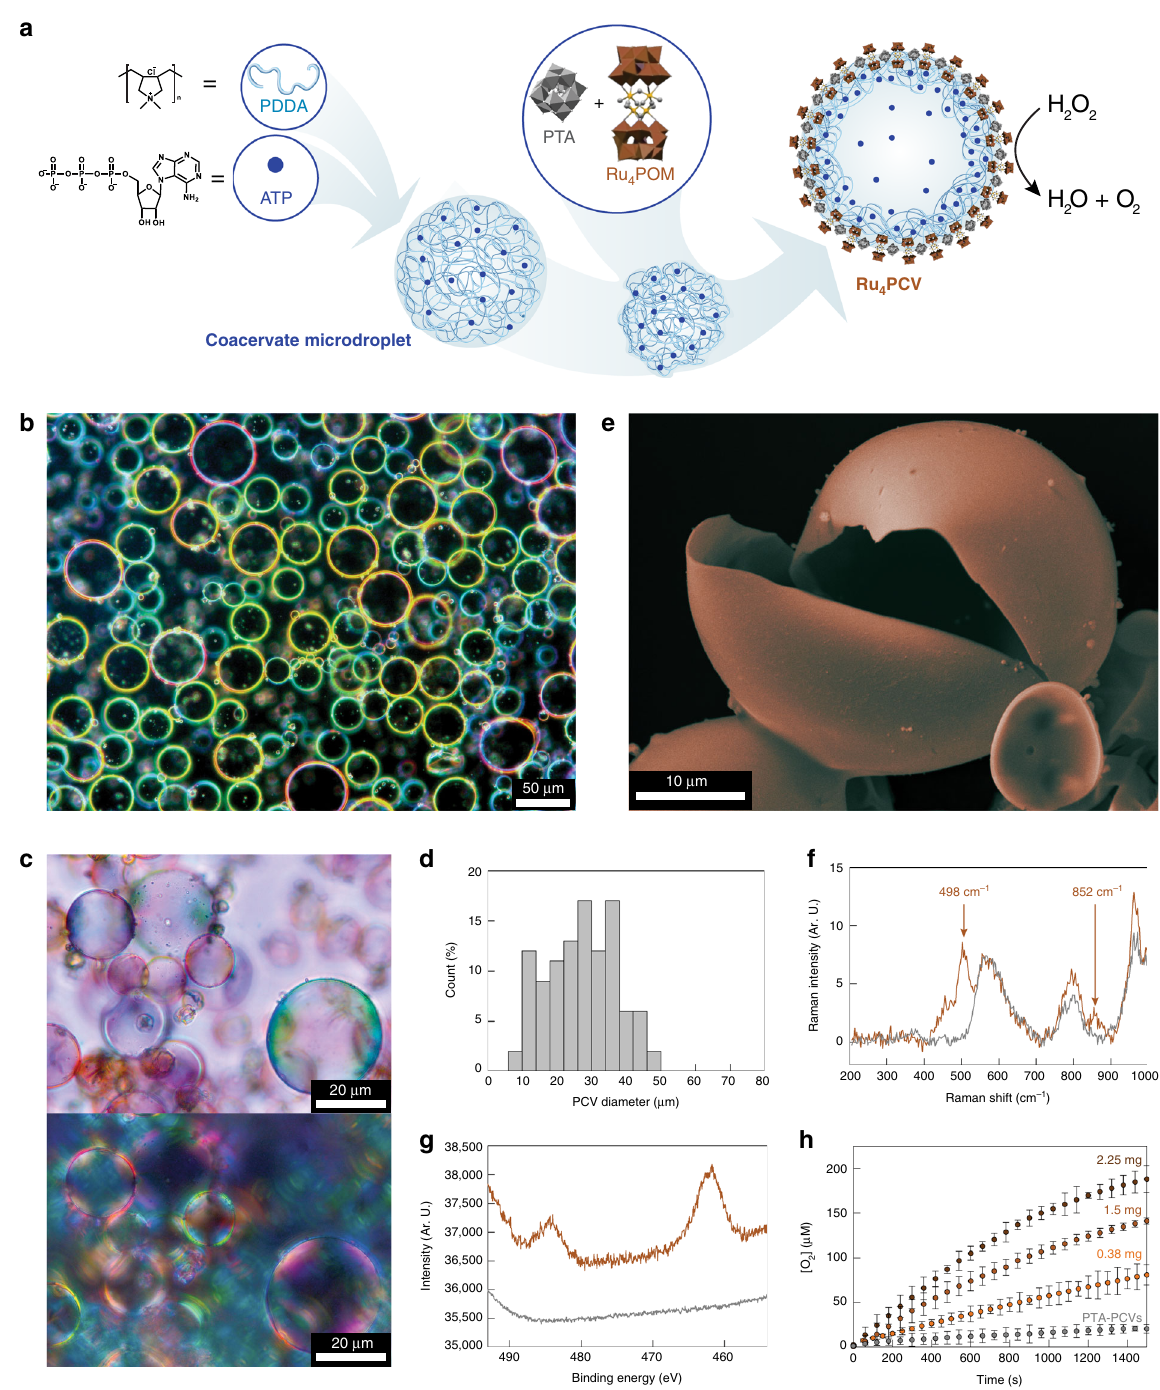
Fig. 1 Self-assembly and catalytic activity of synzyme protocells. a Scheme showing the self-assembly of catalytic Ru 4 PCVs. Membrane-free non- catalytic PDDA/ATP coacervate micro-droplets are recon fi gured into catalytic membrane-bounded coacervate vesicles by electrostatically induced surface binding of Ru 4 POM and PTA polyanions. Membrane formation is accompanied by changes in osmotic pressure that generate a three-tiered micro- architecture consisting of a Ru 4 POM/PTA/PDDA catalytic membrane, a PDDA/ATP sub-membrane coacervate shell, and an expanded aqueous lumen. b Dark- fi eld microscopy image showing a population of Ru 4 PCVs in aqueous solution. c Bright- fi eld microscopy image of a lyophilized sample of Ru 4 PCVs (top), and corresponding cross-polarized image (bottom) showing birefringence. d Size distribution for Ru 4 PCVs produced by addition of a Ru 4 POM/PTA mixture (7:1 molar ratio) to coacervate microdroplets after 30 s of stirring. e SEM image of a lyophilized single Ru 4 PCV showing hollow interior and smooth outer membrane surface. Images have been arti fi cially colored to mimic the real tinge of the material. f Raman spectra of lyophilized Ru 4 PCVs (light brown) and PTA-CVs (gray) powders. Absorbance bands: 498 cm − 1 (Ru – O – Ru str , Ru 4 ( μ – O) 4 ); 852 cm − 1 (Si – O str , [ γ -SiW 10 O 36 ] 8 − ); 575 cm − 1 (O – P – O def ); 798 cm − 1 (W – O – W def ); 978 cm − 1 (W = O str ) 40,52,53 . g XPS spectra (Ru 3p region) of lyophilized Ru 4 PCVs (light brown) and PTA-CVs (gray) powders. Photoemission lines for Ru(IV) are observed at 484.5 eV (3p 1/2 ) and 462.5 eV (3p 3/2 ) 54,55 in the Ru 4 PCV sample. h Room temperature kinetic plots of dioxygen evolution against Ru 4 PCVs concentration (mg in PBS buffer (500 μ L, 10 mM, pH 6.5, Ar purged)) at [H 2 O 2 ] = 2.8 M showing protocell-mediated synzyme activity. Absence of activity for the PTA-CVs control samples is also shown. Error bars: standard